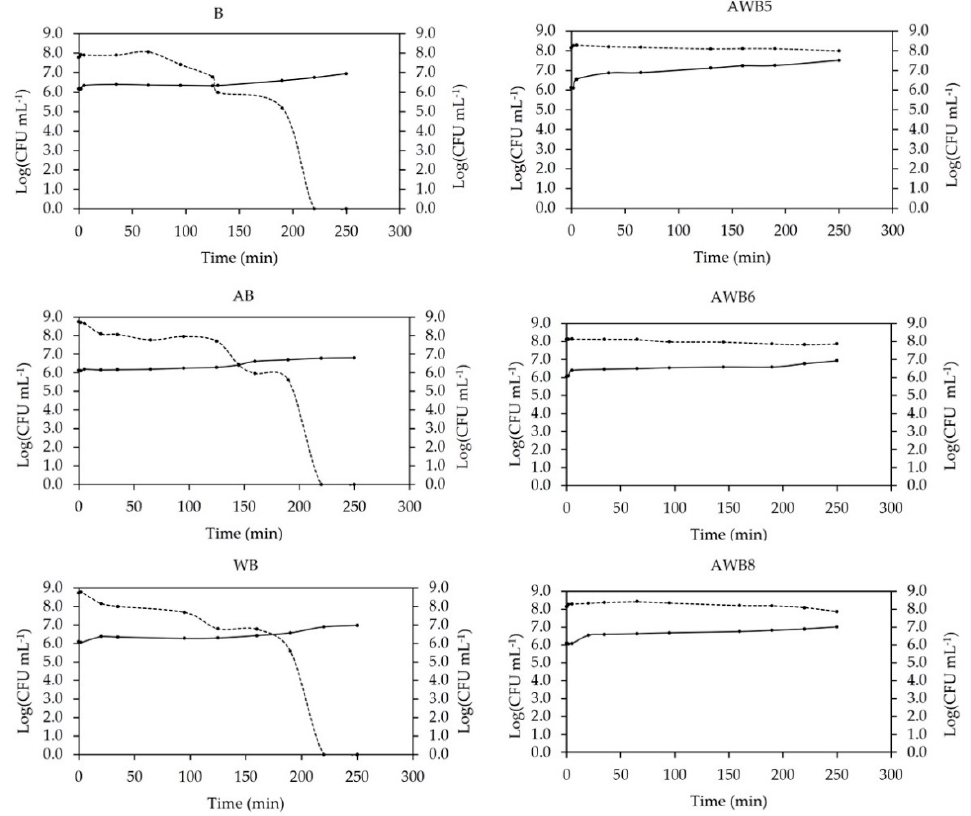
Figure 7. Concentration of S. boulardii detected in the medium vs. amount of live S. boulardii inside the beads. (line): release of S. boulardii , (dotted line): plate count of S. boulardii .